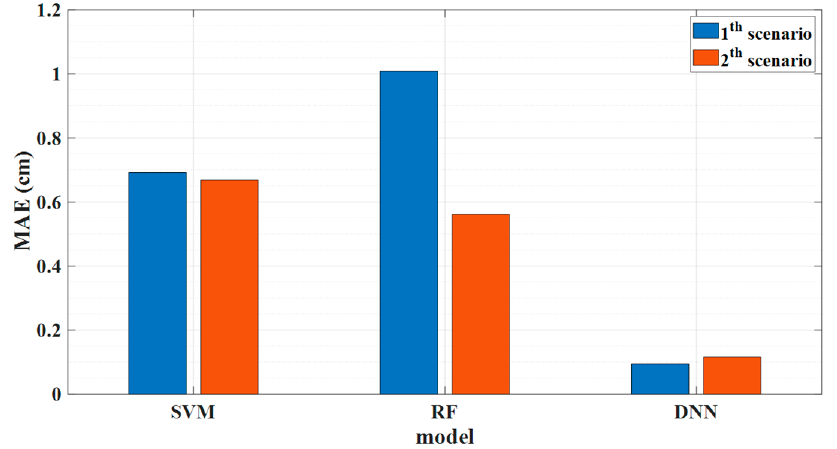
Figure 8. Depiction of the mean absolute error (MAE) of experimental results for the support vector machine (SVM), random forest (RF), and deep neural network (DNN) algorithm. Additionally, to affirm the competence and capability of the proposed system, a simulation of the system with five sensors was conducted. All five sensors (S11–S51) are considered to work in the same operating wavelength range (1547 nm to 1550 nm). The water level of S11 changed from 0 to 34 cm, while the water level of other sensors (S21–S51) is set to be 5.7, 12.5, 19.4, and 26.2 cm, respectively. Thus, the reflected spectra of five FBGs (i.e., training dataset) at different water level steps are collected by simulation using Equation (4). The computer-simulated reflected spectrum data of five sensors are displayed in Figure 9a. As shown in the figure, it can be seen some of the spectra of two FBGs are partially or fully overlapped. To train the DNN, we generated a dataset that consists of five sensors’ reflected spectra. Afterward, the DNN model is trained with the dataset, and to prove the performance of the well-trained model, we use unseen testing data of five sensors’ reflected